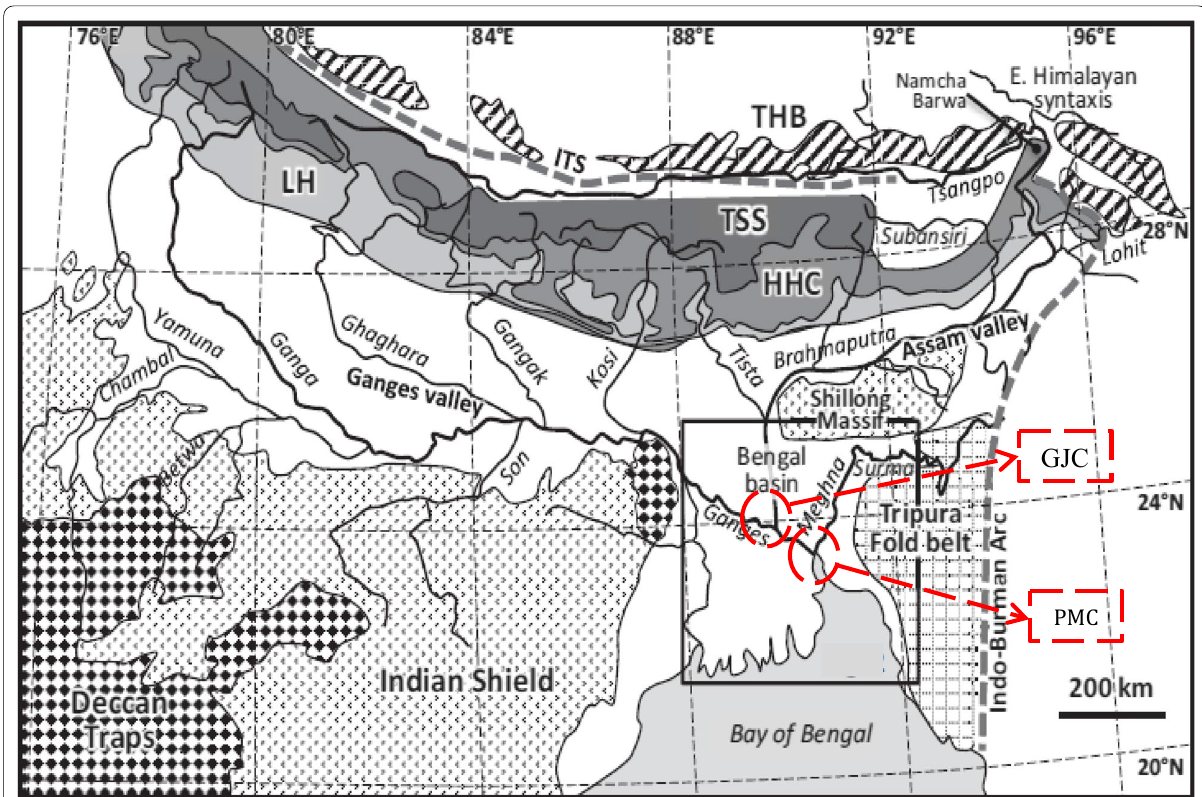
Fig. 1 Map of the Ganges–Brahmaputra–Meghna river basin representing major tributaries and sediment sources including Trans-Himalayan batholiths (THB), Tethyan Sedimentary Series (TSS), High Himalayan Crystalline Sequence (HHC), Lesser Himalayas (LH), Indus-Tsangpo suture (ITS) (after Goodbred et al. 2014). The rectangle focuses on the Bengal basin that influences the river migration and sediment dispersal across the Ganges–Brahmaputra–Meghna delta. GJC and PMC indicate the Ganges–Jamuna confluence and Padma–Meghna confluence, respectively